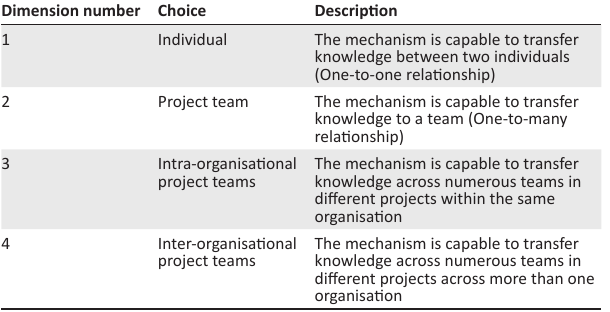
TABLE 3: Reach dimension.